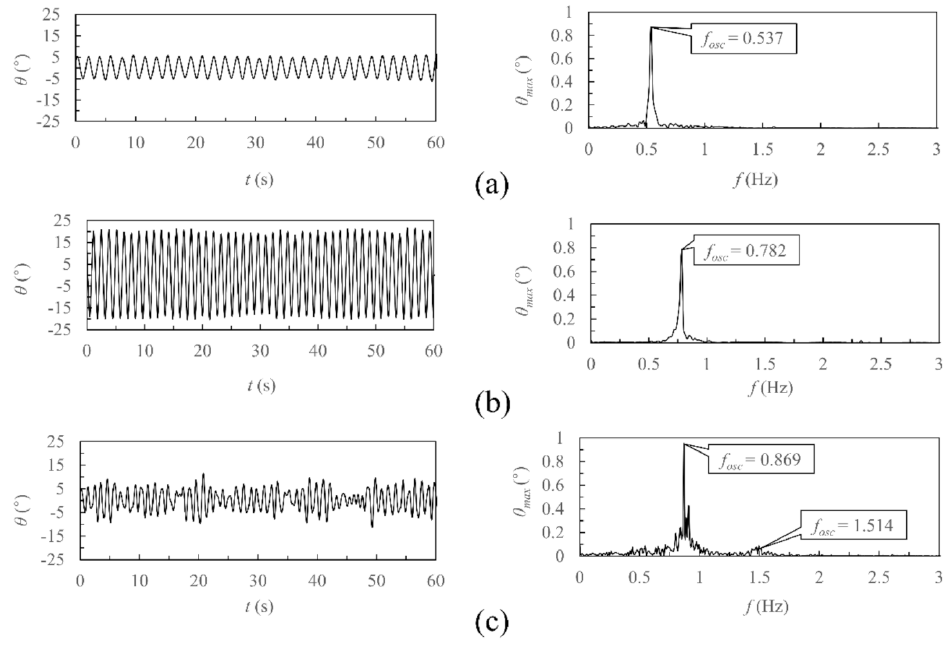
Figure 15. Rotational oscillation time history and spectral characteristics at three typical velocities when L / D = 5.0: ( a ) U = 0.302 m/s ( U r = 2.877); ( b ) U = 0.556 m/s ( U r = 5.302); ( c ) U = 0.810 m/s ( U r = 7.726).